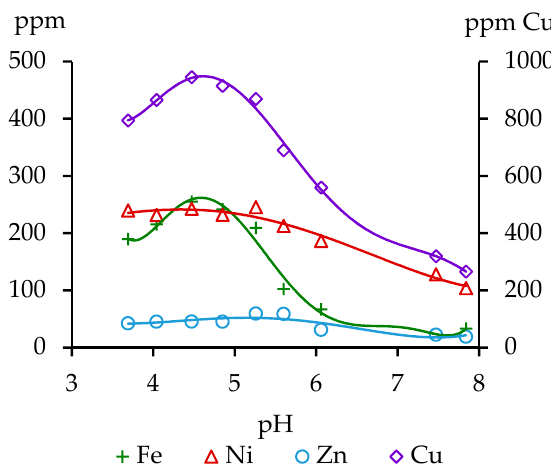
Figure 1. Comparison in level of the metal extraction at different pH of ammonium acetate buffer (AAB).